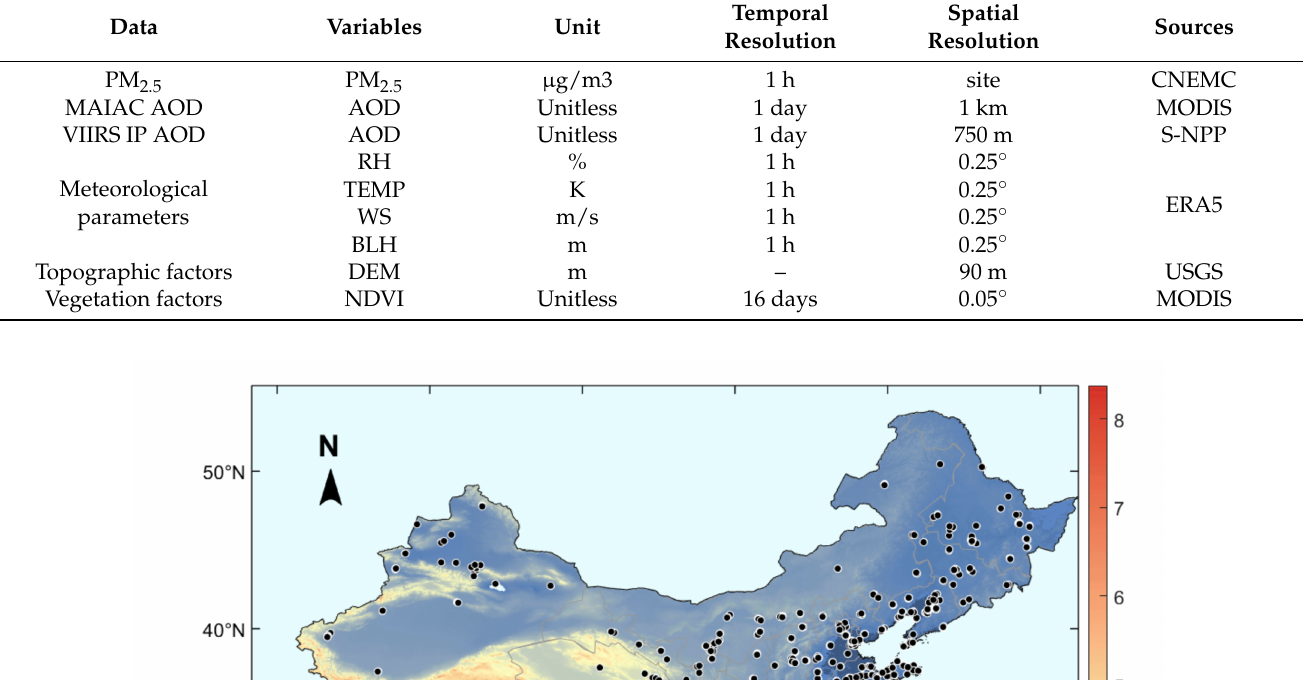
Table 1. Datasets used in this study. AOD: aerosol optical depth; RH: relative humidity; TEMP: temperature; WS: wind speeds; BLH: boundary layer height; NDVI: normalized difference vegetation; DEM: digital elevation model.